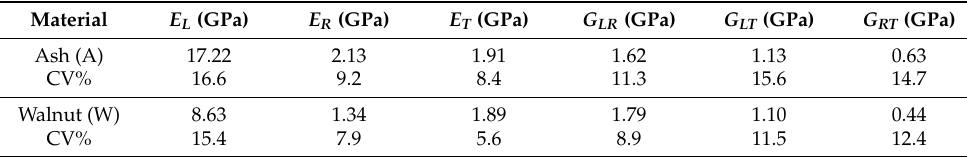
Table 2. Moduli of elasticity in longitudinal ( E L ), radial ( E R ) and tangential direction ( E T ) and shear moduli ( G LR , G LT , G RT ) of ash and walnut wood, used for body of tested electric guitars (CV%—Coefficient of